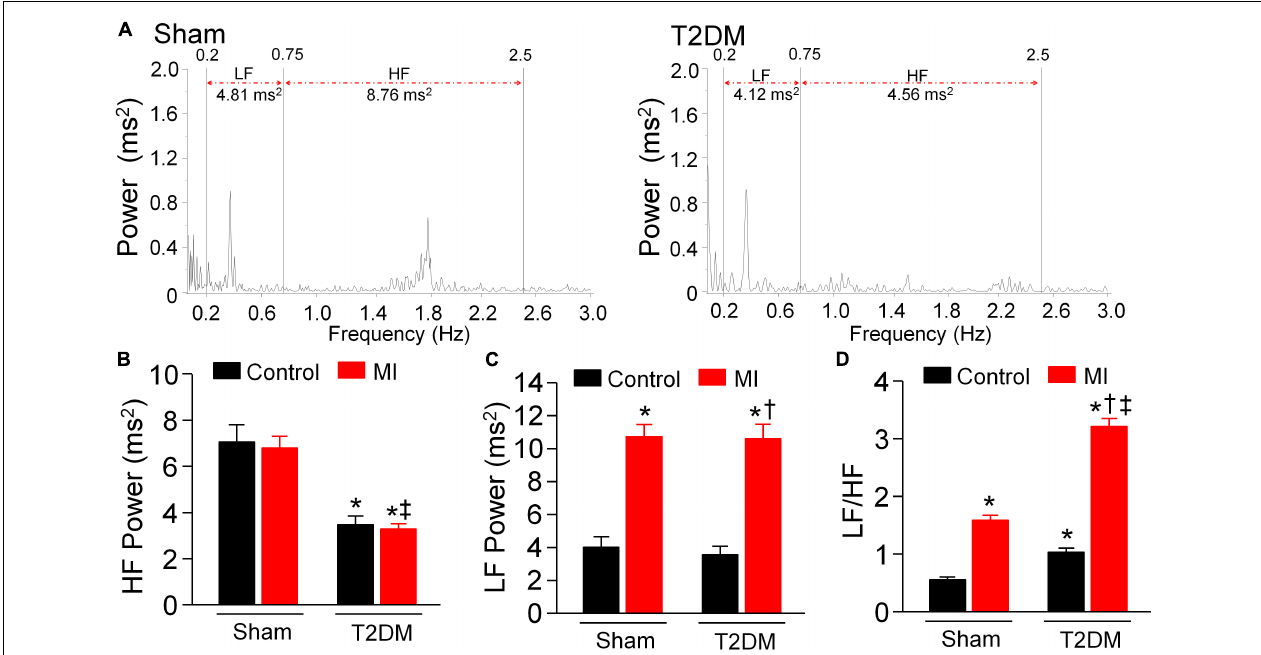
FIGURE 5 | Cardiac autonomic function measured by heart rate variability (HRV) in all experimental groups of conscious rats. (A) : Representative data showing HRV measured in sham (left) and T2DM (right) rats. Spectral power was quantified for low-frequency power (LF) from 0.2 to 0.75 Hz and high-frequency power (HF) from 0.75 to 2.5 Hz. (B–D) : Quantitative data of HF (B) , LF (C) , and LF/HF ratio (D) from all groups of rats. T2DM reduced HF power. MI increased LF power and LF/HF ratio in sham (sham+MI) and T2DM (T2DM+MI) rats. MI-increased LF/HF ratio was higher in T2DM (T2SM+MI) rats than that in sham (sham+MI) rats. Data are means ± SEM; n = 6 rats per group. Statistical significance was determined by one-way ANOVA with post-hoc Bonferroni test. * P < 0.05 vs. sham; † p < 0.05 vs. T2DM; ‡ p < 0.05 vs.